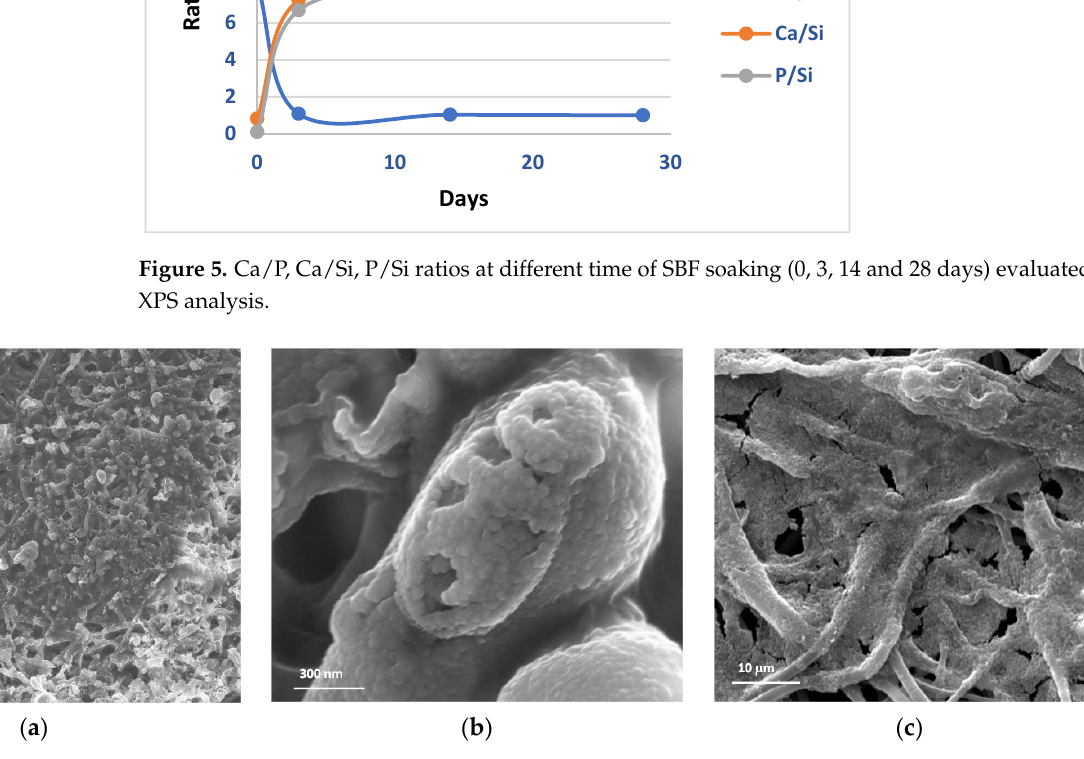
Figure 6. SEM images of the coated polymeric scaffold at different times of soaking in SBF ( a ) 7 days; ( b ) 14 days; ( c ) 28